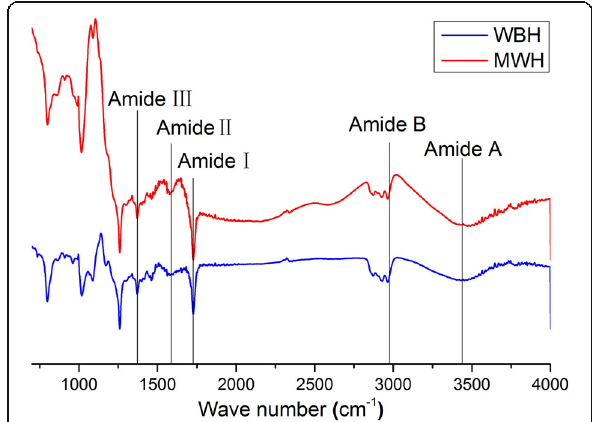
Fig. 6 FT-IR spectra of aluminum tanned skin pieces under different heating methods